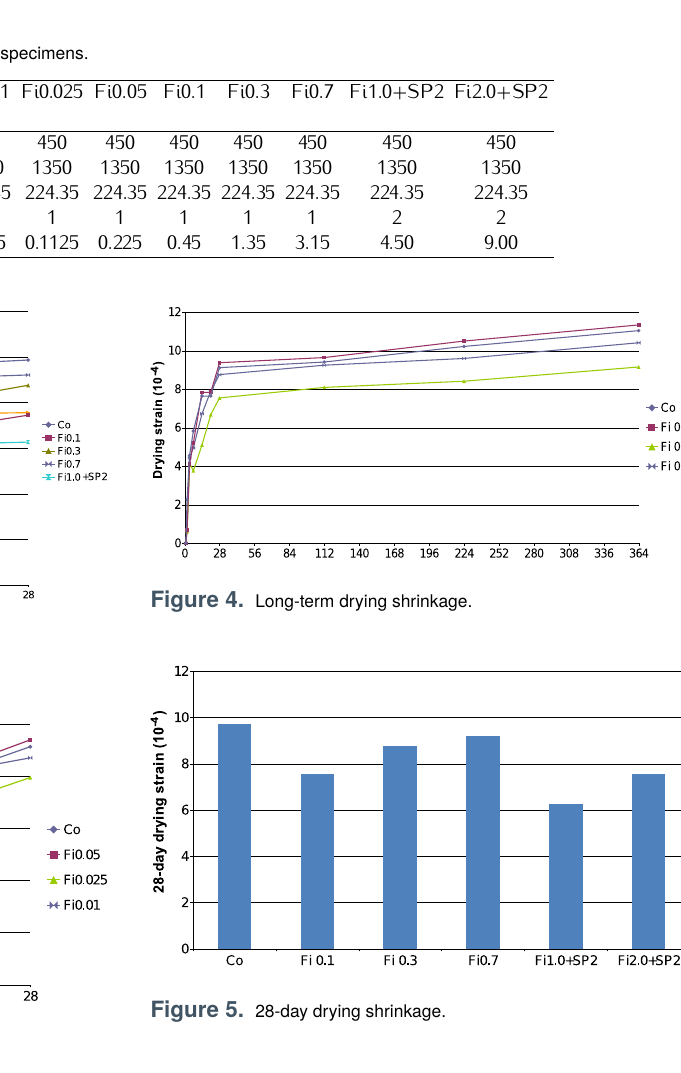
Figure 3. Drying shrinkage of mixes.